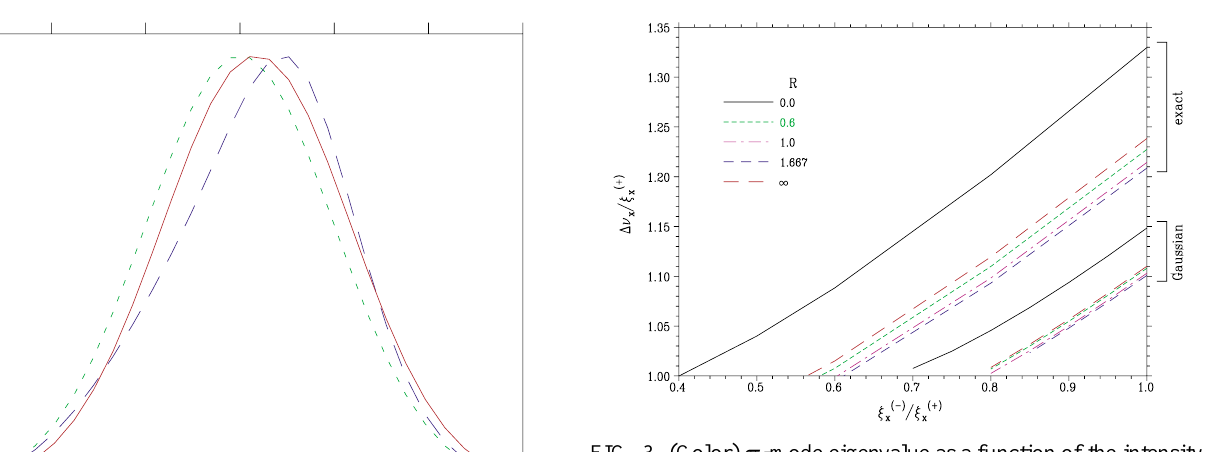
FIG. 3. (Color) p -mode eigenvalue as a function of the